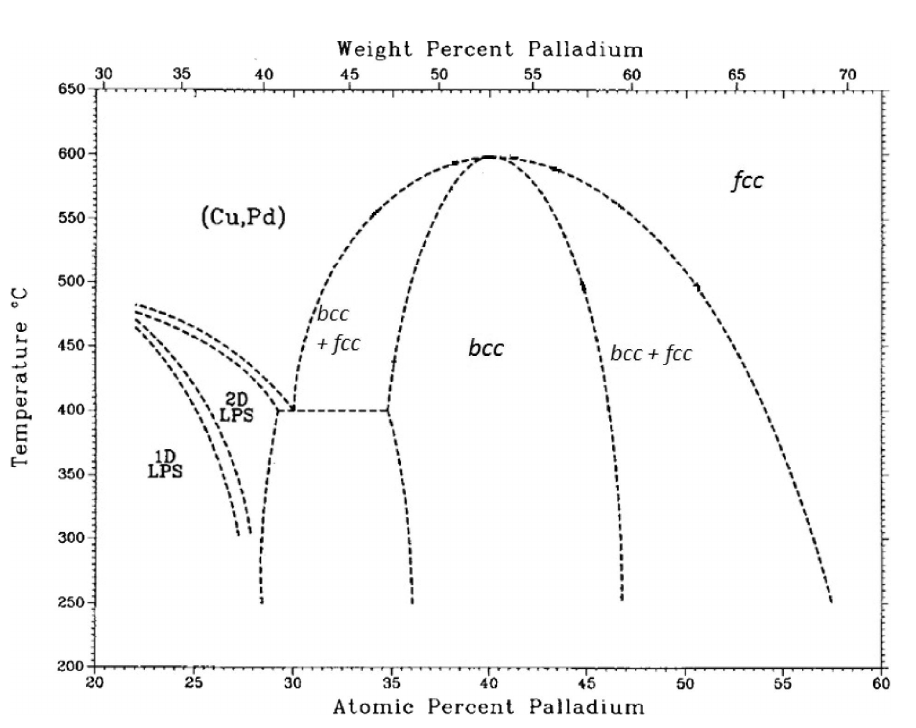
Figure 12. Pd-cu phase diagram [205], with permission from © Elsevier.